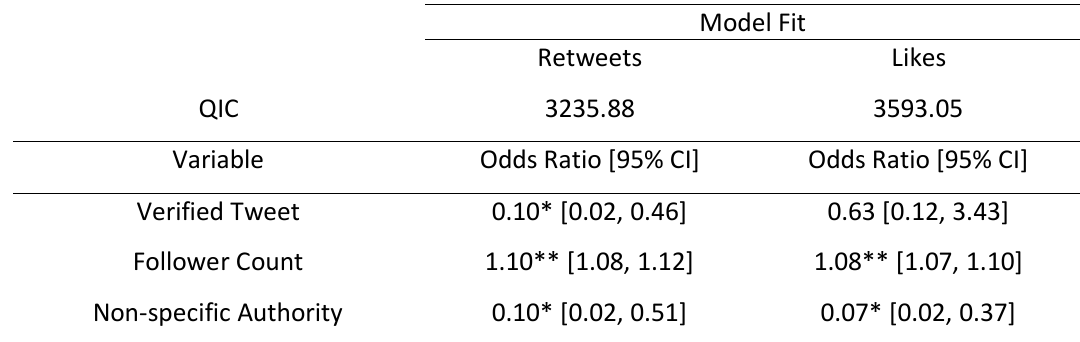
Table 2. Misinformation GEE logistic regression coefficients for likelihood of retweets and